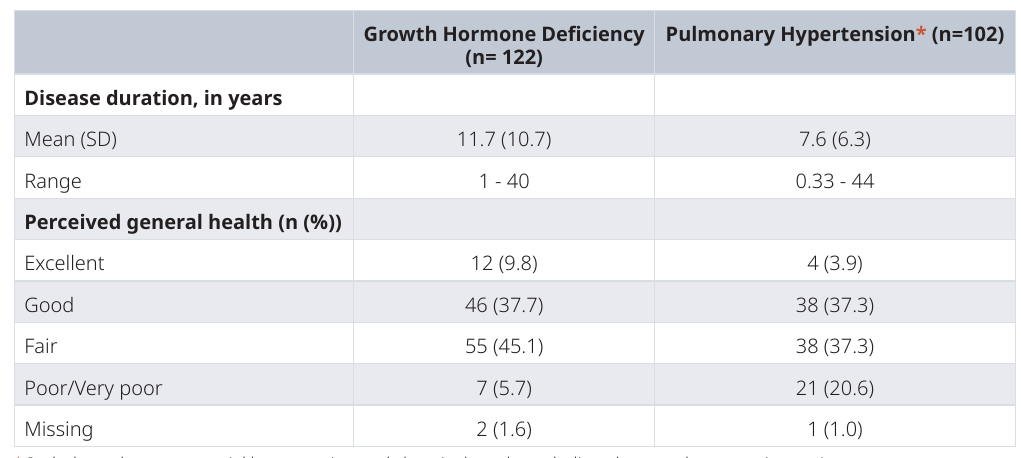
Table 5. Disease duration and perceived general health of adult Growth Hormone Deficiency and Pulmonary Hypertension samples.